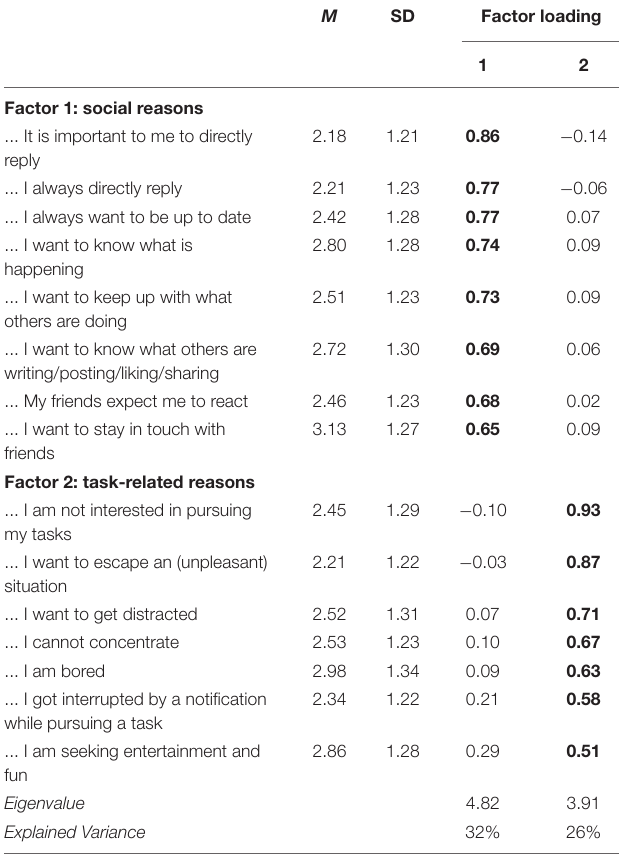
TABLE 5 | Exploratory factor analysis of reasons for distraction.